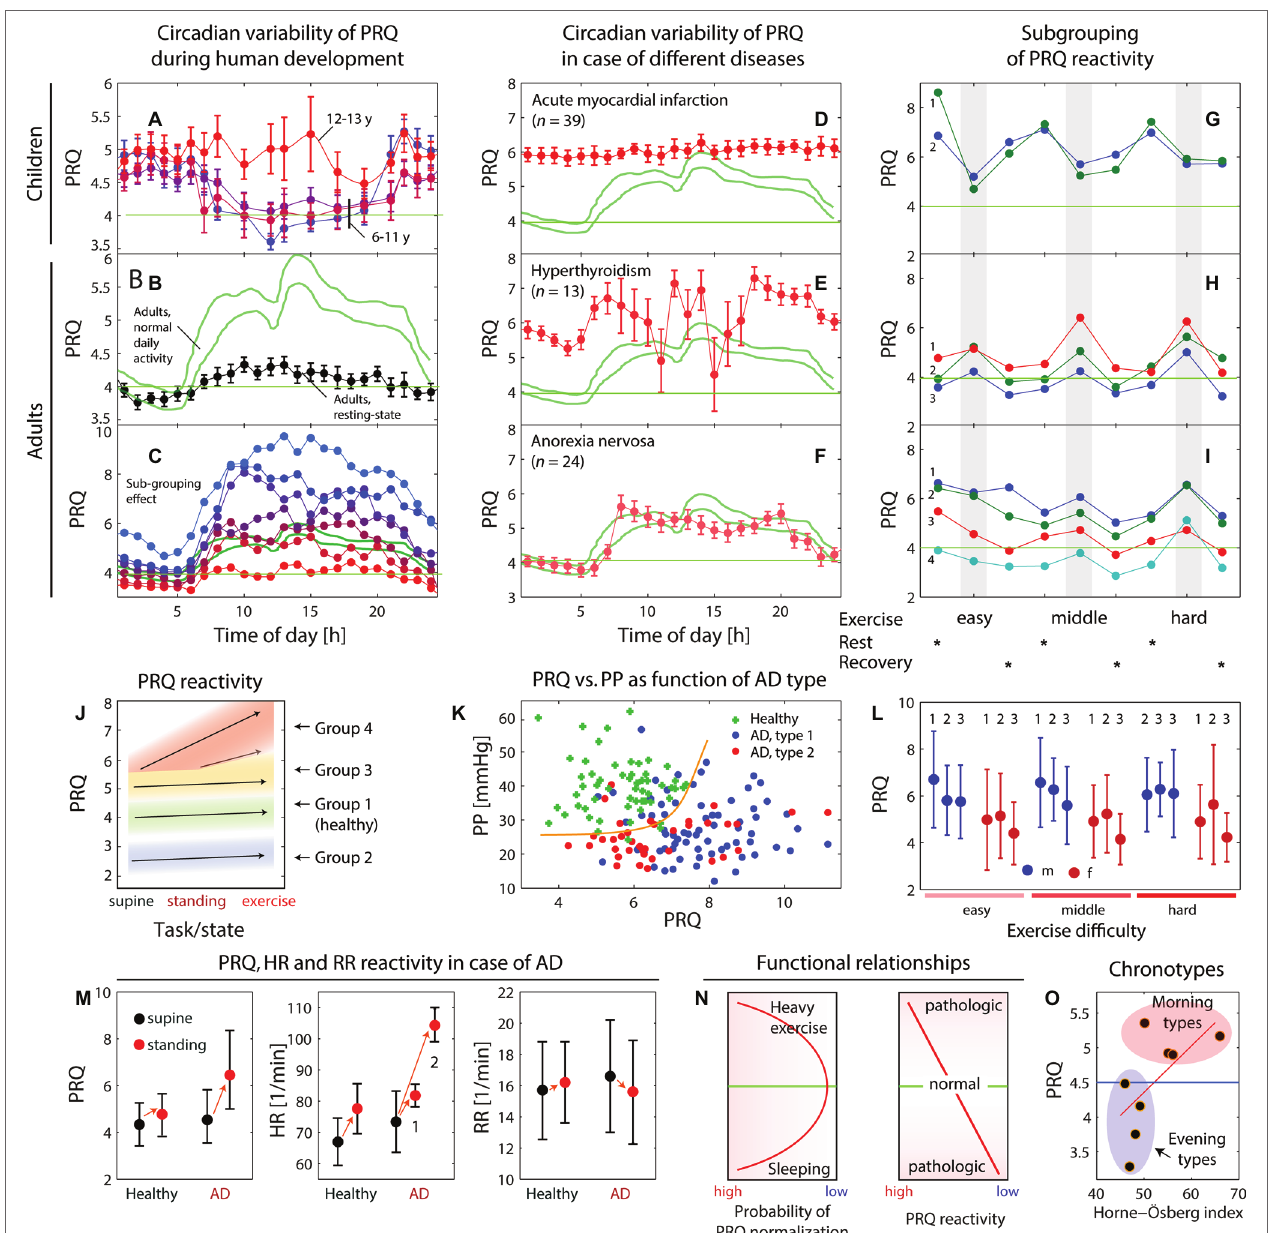
FIGURE 3 | (A–C) Dependence of the circadian pulse-respiration quotient (PRQ) oscillation on age and measurement condition (data extracted from Breithaupt et al., 1980 and Heckmann, 2001). The green lines in (B,C) indicate reference ranges for unrestricted PRQ (u-PRQ) values obtained from 24-h measurements in adults (according to Heckmann 2001). The values with error bars (standard error of the mean) in (A,B) refer to a study by Breithaupt et al. (1980) involving children ( n = 47) and adults ( n = 50). (C) Findings of Heckmann (2001) that the u-PRQ shows large inter-personal variability and can be classified into subgroups (each color represents a subgroup of 7 in total, subgrouping according to the mean PRQ over 24 h; 1: PRQ > 6.75, n = 18; 2: PRQ = 6.25–6.75, n = 11; 3: PRQ = 5.75–6.25, n = 11, 4: PRQ = 5.25–5.75, n = 15; 5: PRQ = 4.74–5.25, n = 10; 6: PRQ = 4.25–4.75, n = 13, 7: PRQ < 4.25, n = 12). (D–F) Circadian PRQ variability for different diseases (data extracted from Heckmann, 2001; u-PRQ values, green lines: reference range for healthy adults). (G–I) Example of the subgrouping effect for functional PRQ (f-RRQ) values obtained during an experiment with three different exercise strengths. Data extracted from Bräuer et al. (1973); (G) 1: men (m), 2: m; (H) 1–2: m, 3: women (w); (I) 1–4: w. (J) Subgrouping effect of PRQ reactivity (f-PRQ values dependent on three conditions: supine, standing, and exercise). Data extracted from Suchantke (1951). (K) Relationship between the pulse pressure (PP) and the f-PRQ values during standing for healthy controls ( n = 56) and subjects with autonomic dysfunction (AD) ( n = 105) experiencing bradycardia during standing as well ones with tachycardia. The PR-PRQ mapping enables these three groups to be separated efficiently, indicating that the cardiovascular reactivity is different for each group. Data extracted from Weckenmann (1981). (L) Changes in the PRQ due to physical exercise of different intensities. The f-PRQ measurements have been obtained from men ( n = 21, blue dots) and women ( n = 20, red dots). 1: baseline,